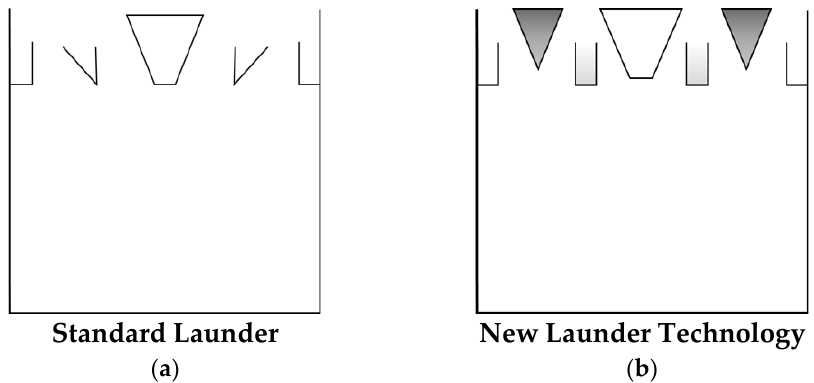
Figure 1. Launder designs for TankCell ® e630 cell: ( a ) standard launder (baseline) and ( b ) new launder technology (upgrade).